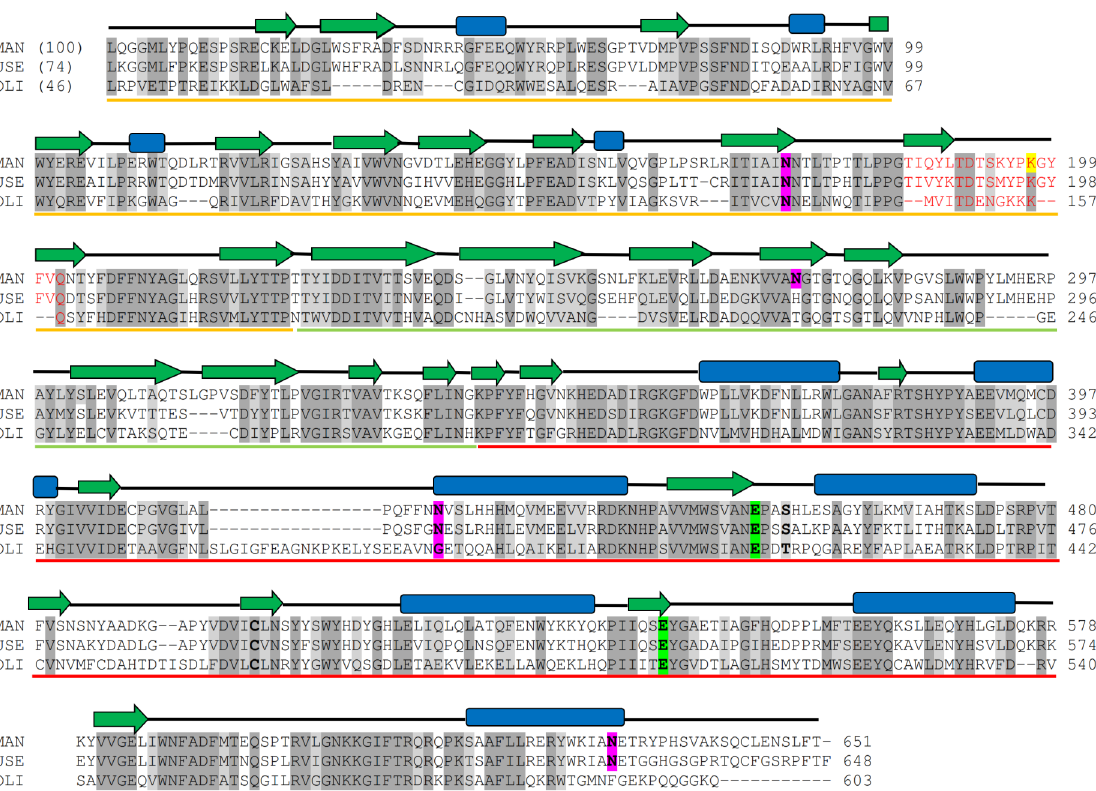
Fig 1. Multiple sequence alignment of human GUS with mouse and bacterial GUS. The percent sequence identities are given in parentheses. Completely conserved residues and homologous residues are shaded in dark and light grey, respectively. The secondary structure elements are given on the top of sequences, where α -helices are represented by blue rectangles, β -strands by green arrows. Domains 1, 2 and 3 are indicated by yellow, green and red line respectively, below the sequence. Conserved active site residues are highlighted in green boxes. Potential glycosylation sites are in pink. Glycosylation sites are in magenta boxes. Amino acid sequences of GUS were taken from the Uniprot database with their primary accession number as: human, P08236; mouse P12265; and E. coli,